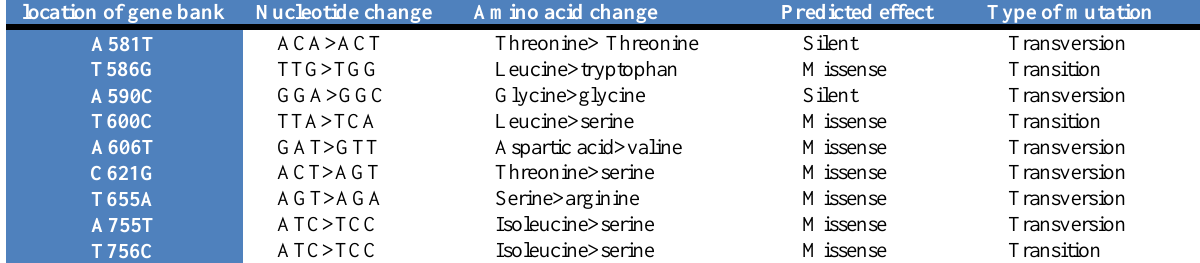
Figure, 3: Sequencing of sense flanking the exon 2 of GnRHR gene, for cases of ewes , obtained from Gene Bank. Table, 3: Type of polymorphism and amino acid change in sense of GnRHR gene in sheep.